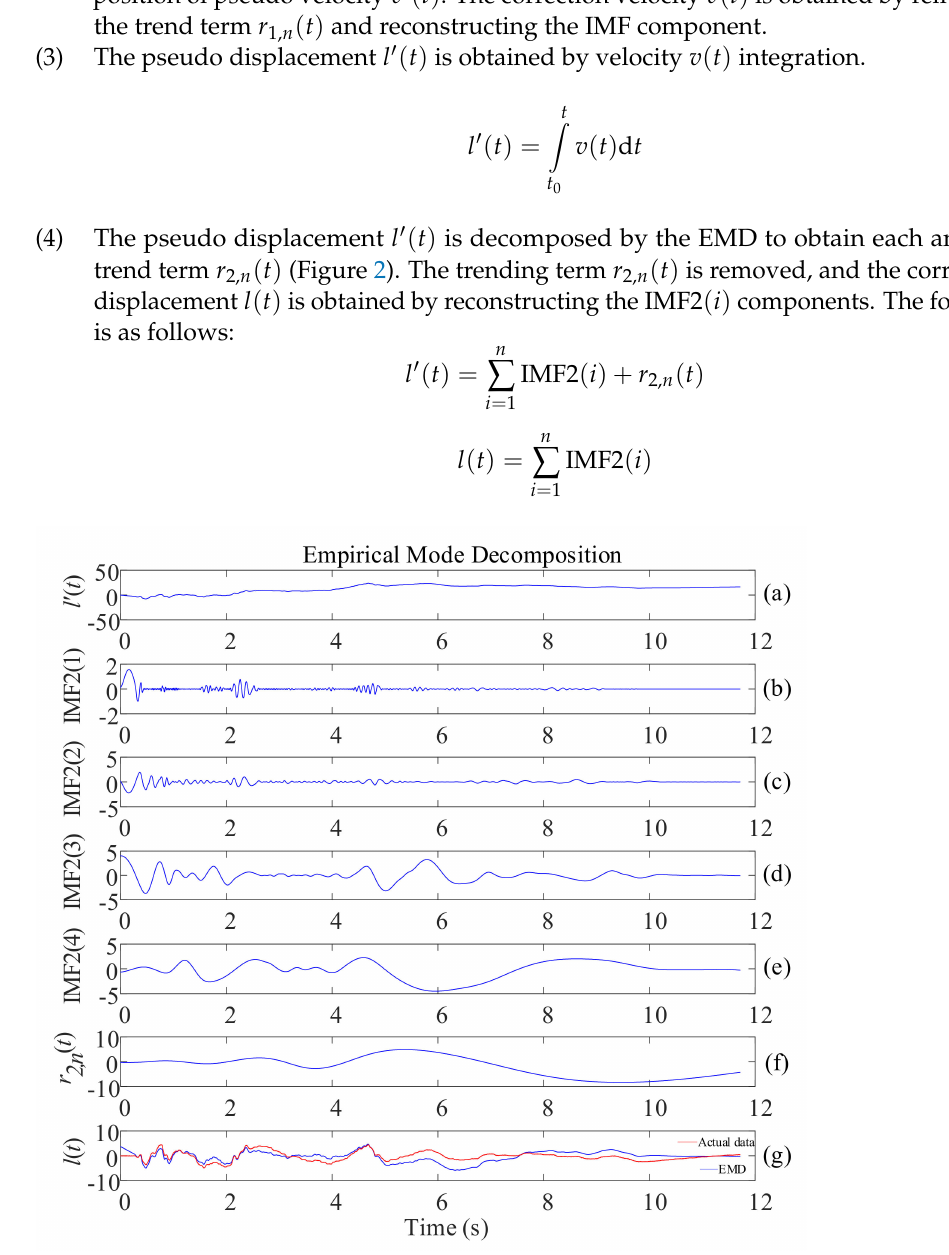
Figure 2. Example of EMD: ( a ) pseudo displacement; ( b – e ) different IMFs of the signal; ( f ) residual of the signal; ( g ) the displacement obtained from EMD and the actual displacement